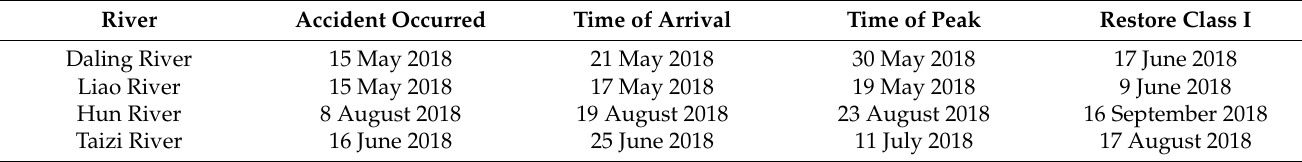
Table 5. Pollutants into the sea, peak present and receding times of the sudden water pollution accident of the river into the